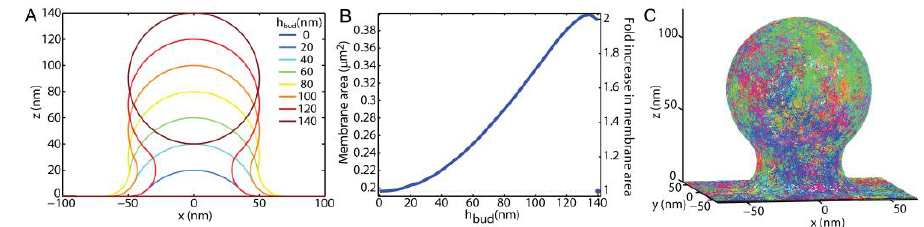
Figure 1. Simulations were performed by mimicking the membrane topography throughout the fission and fusion of a single 50 nm radius vesicle with a planar membrane. ( A ) By maintaining a 50 nm radius of curvature on top and a smooth, 20-nm radius of curvature connection to the surrounding membrane, the stage of membrane budding was tracked via the maximum bud height above the surrounding membrane ( h bud ); ( B ) Bud growth results in an increased area of total membrane within a 250 nm of the bud center. When h bud > 137 nm, the bud undergoes fission, a separate vesicle is formed, which is assumed to diffuse away and not contribute to these simulations; ( C ) Simulated trajectories are shown in assorted colors over a membrane topography with h bud = 120 nm.